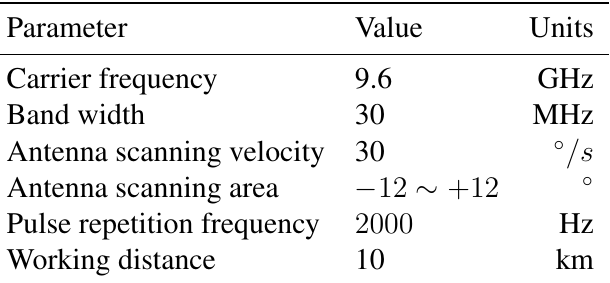
Table 1. Simulation